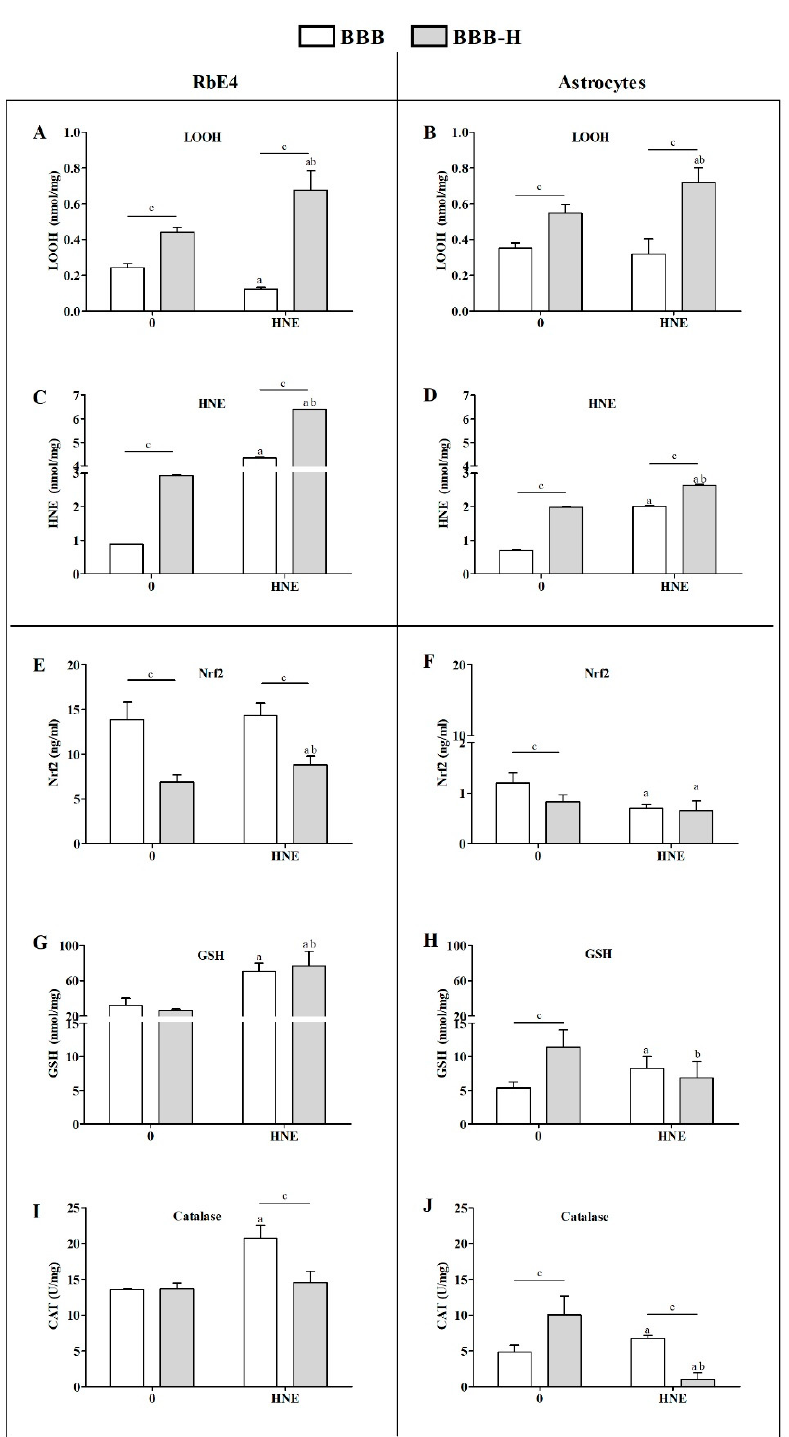
Figure 4. Oxidative and antioxidative status of RbE4 cells and astrocytes of BBB and BBB-H model at control conditions (0) and 20 µM HNE treatment. Measurements of LOOH and HNE-protein conjugates levels were performed to assess oxidative status of RbE4 cells ( A , C ) and astrocytes ( B , D ) of both BBB models. Nrf2 and GSH levels with CAT activity were measured as main representatives of antioxidative status of RbE4 cells ( E , G , I ) and astrocytes ( F , H , J ) of both BBB models. All results are represented as mean ± SD, n = 12 samples for each group from 3 independent experiments. a—statistically significant in respect to control (0) on pure collagen, p < 0.05; b—statistically significant in respect to control (0) on modified collagen, p < 0.01; c—statistically significant between groups of same treatment, p < 0.01.